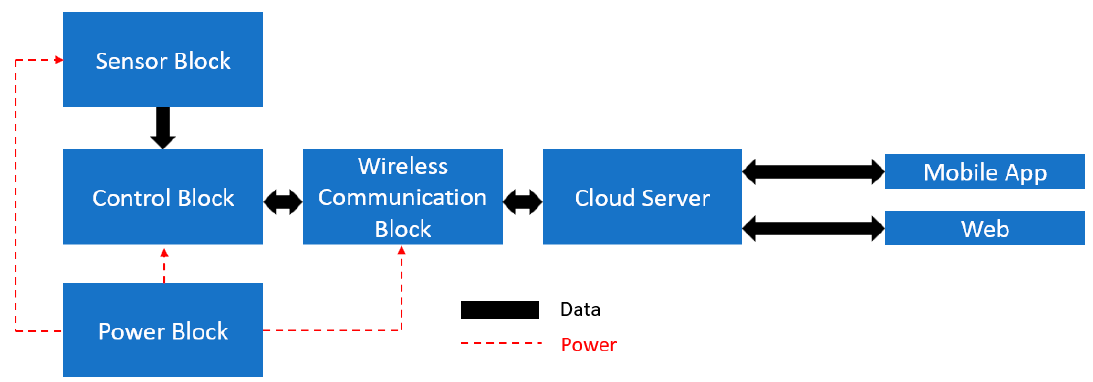
Figure 11. Block diagram of communication and power.